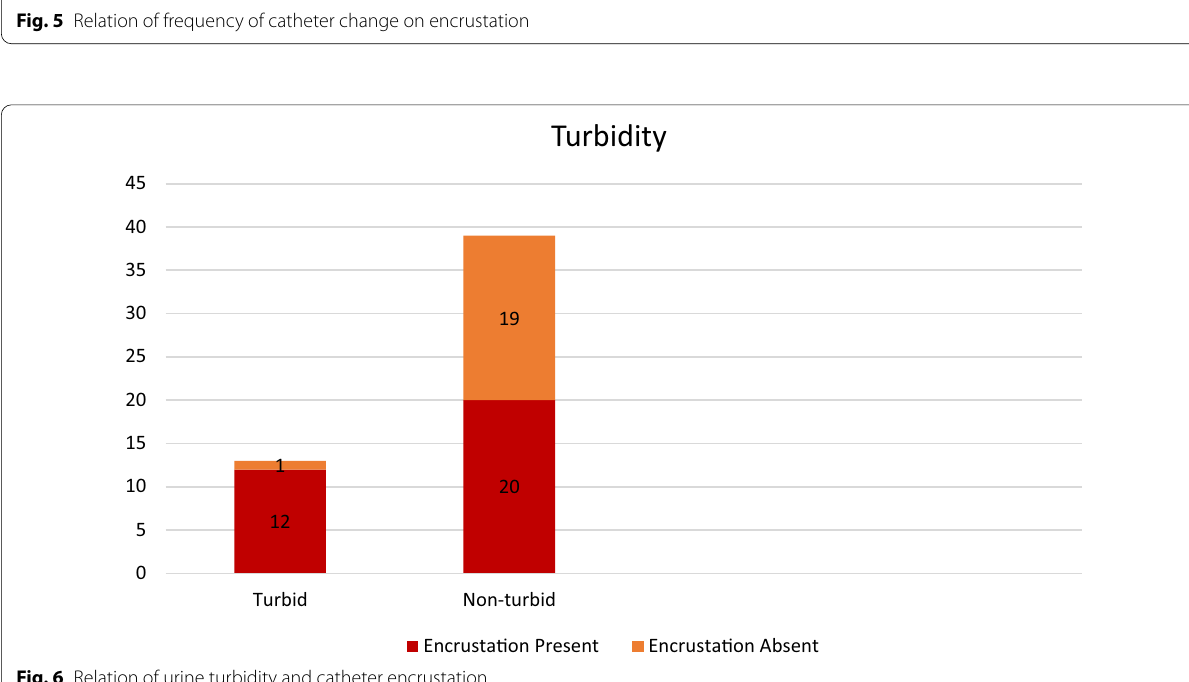
Fig. 5 Relation of frequency of catheter change on encrustation